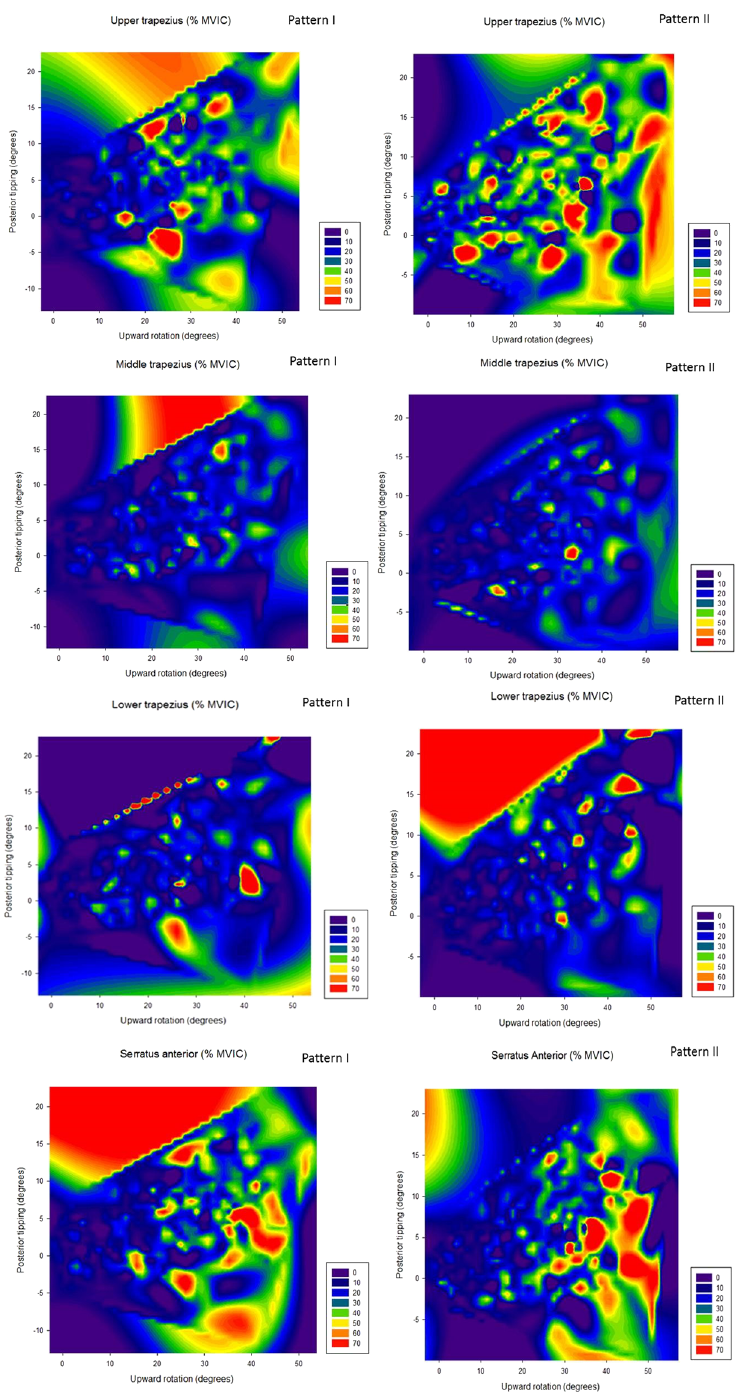
Figure 1. Contour plots of upper/middle/lower trapezius and serratus anterior muscle activity with scapular upward rotation and posterior tipping in X and Y axes, respectively. Pattern I: inferior angle prominence; pattern II: medial border prominence; MVIC: maximal voluntary isometric